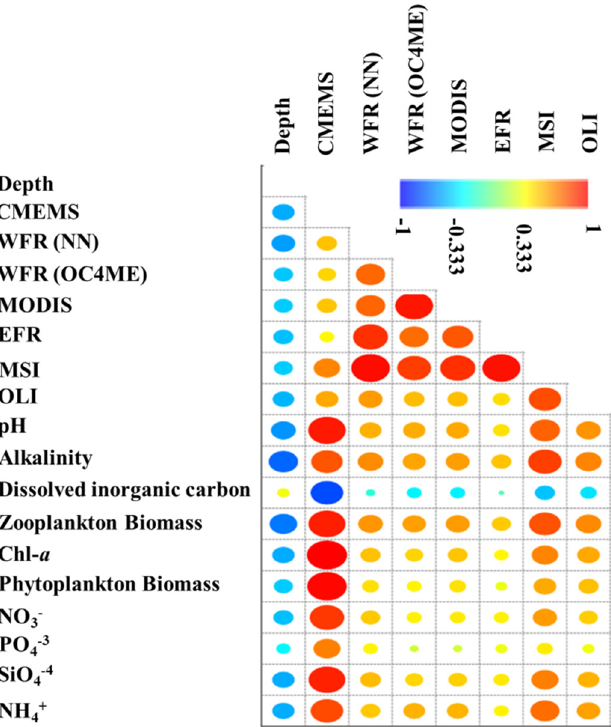
Figure 5. Graphical representation of the Pearson’s correlation coefficients of estimated Chl- a contents against the CMEMS coastal water geochemical parameters.